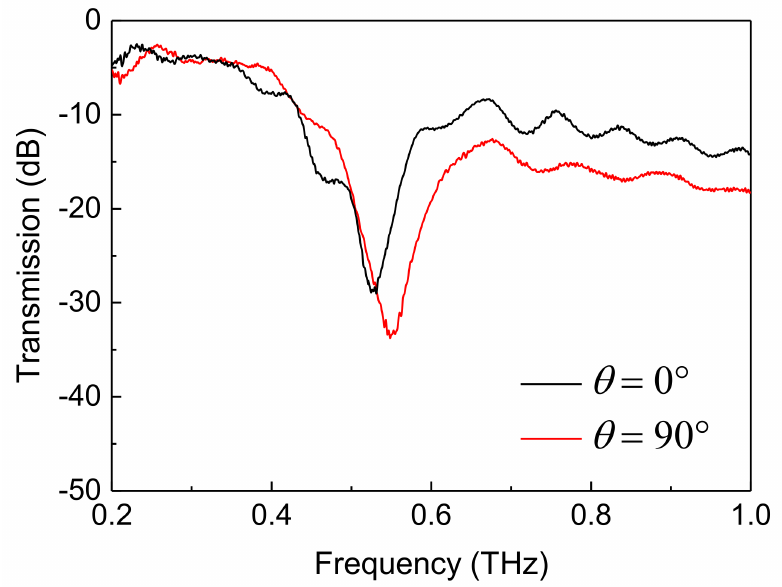
Figure 5. Terahertz spectra of metamaterial-imbedded cells with a liquid crystal (LC) thickness of 710 µ m in spectral resolution of 1